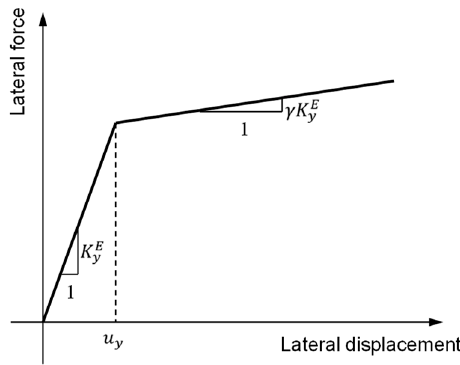
Figure 4. Force-displacement relationship between the lateral force resisting wall components.